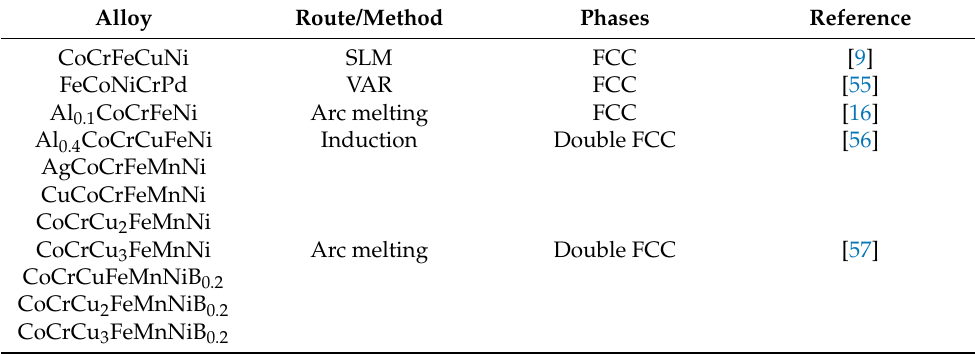
Table 5. BioHEAs with single-phase FCC or dual